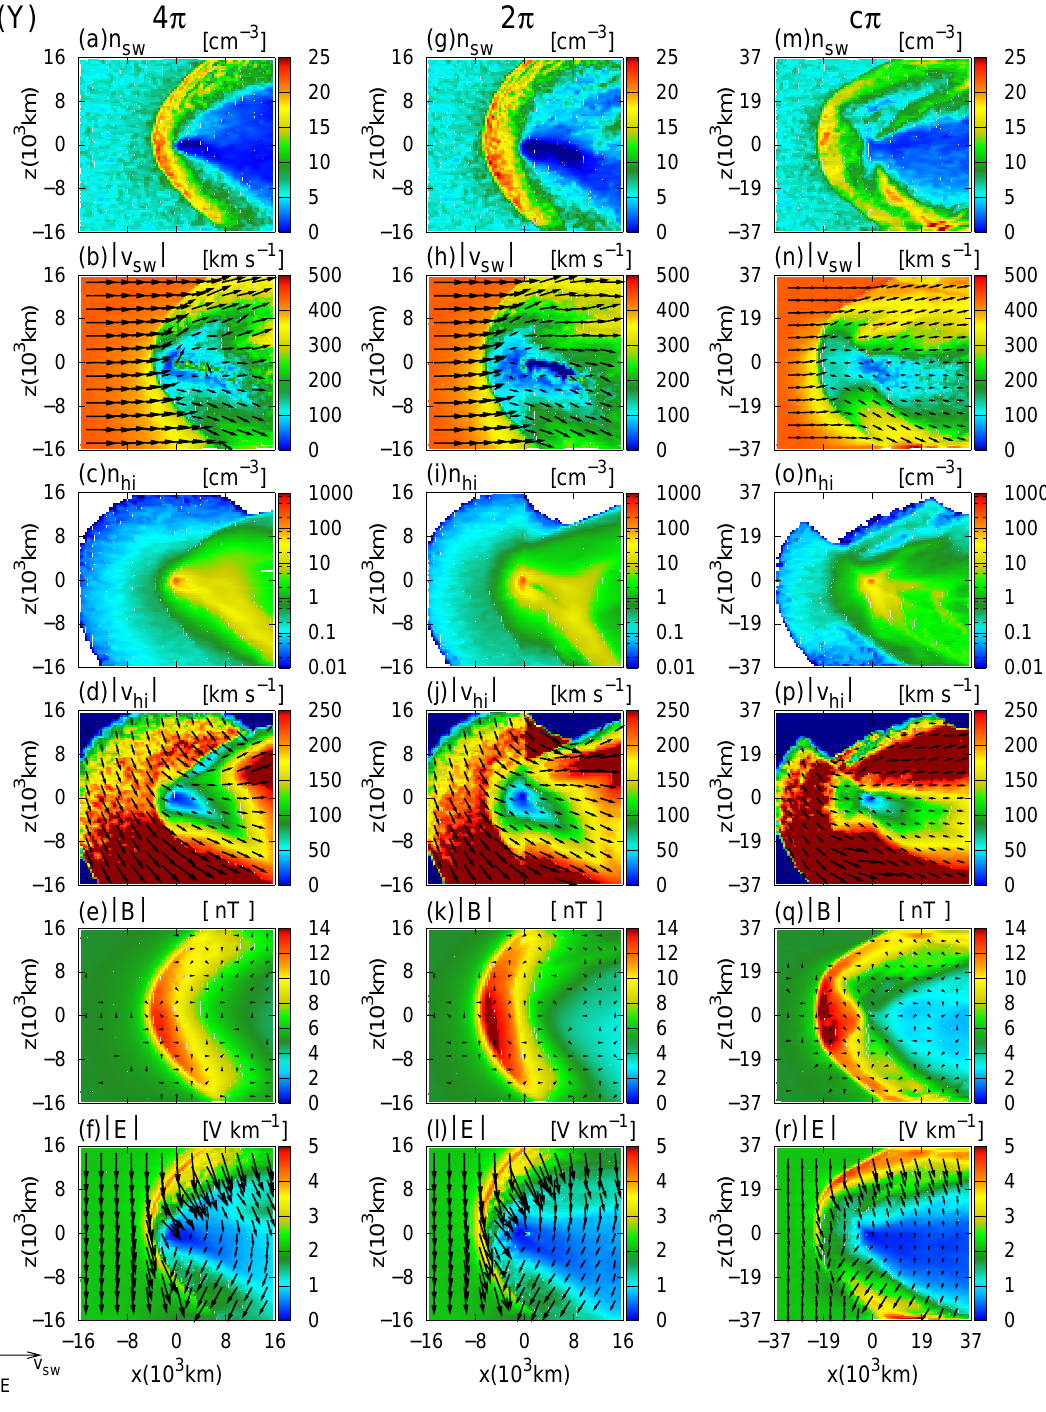
Fig. 6. Cut through the polar plane of the simulation box at 1.30AU. The first column shows the results for the spherically symmetric (4 π ), the middle column for the day side restricted (2 π ) and the third column for the cone shaped model (c π ). We show the solar wind density ( a, g, m ) and bulk velocity ( b, h, n ), the cometary ion density ( c, i, o ) and bulk velocity ( d, j, p ), the magnetic ( e, k, q ) and the electric field ( f, l, r ). The undisturbed solar wind flow points in +x while the convective electric field points in -z direction. Increasing spatial confinment leads in both cases, 2 π and c π , to quantitative modifications of the plasma boundaries while in the c π case we encounter also qualitatively new features. The boundaries are pushed in both cases towards the sun and they exhibit a broadening compared to the 4 π case. Notice the larger spatial scale in case of the c π